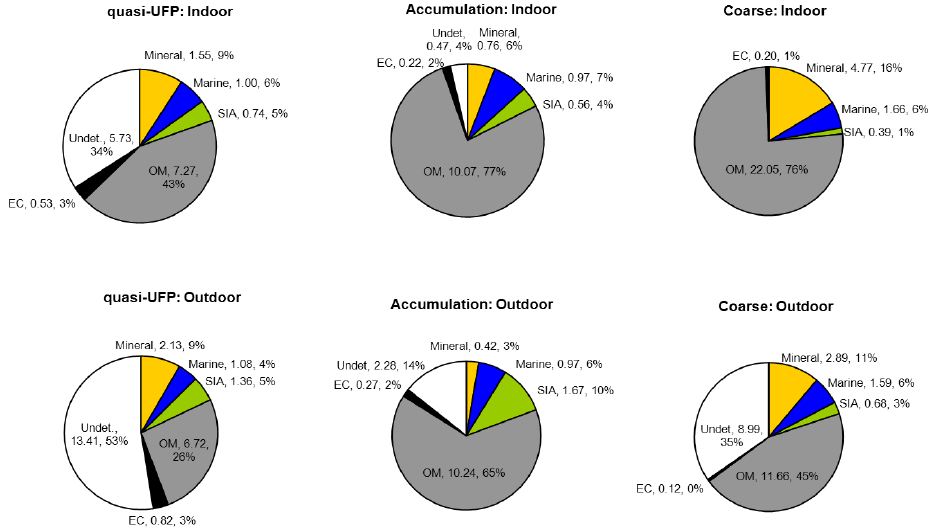
Fig. 1. Average mass closure of coarse (PM 2 . 5 − 10 ) , accumulation (PM 0 . 25 − 2 . 5 ) mode and quasi-ultrafine (quasi-UFP, PM 0 . 25 ) particles in indoor and outdoor school environments. SIA: secondary inorganic aerosols. OM: organic matter. EC: elemental carbon.